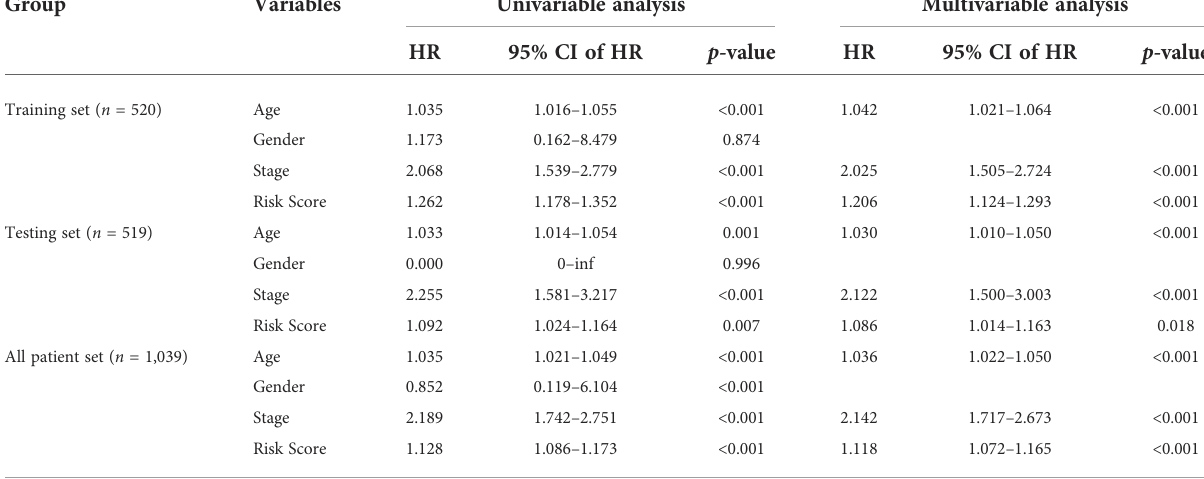
TABLE 3 Univariate and multivariate Cox regression analyses in the training, test, and TCGA sets. Group